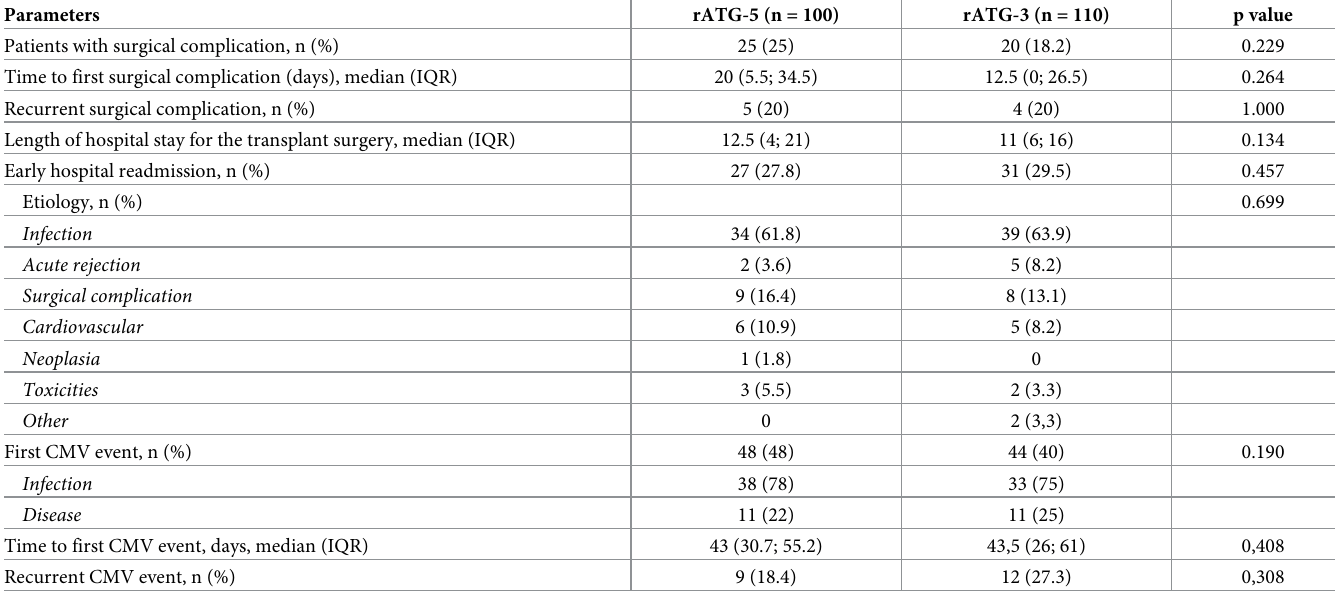
Table 4. Surgical complications, early hospital readmission and CMV